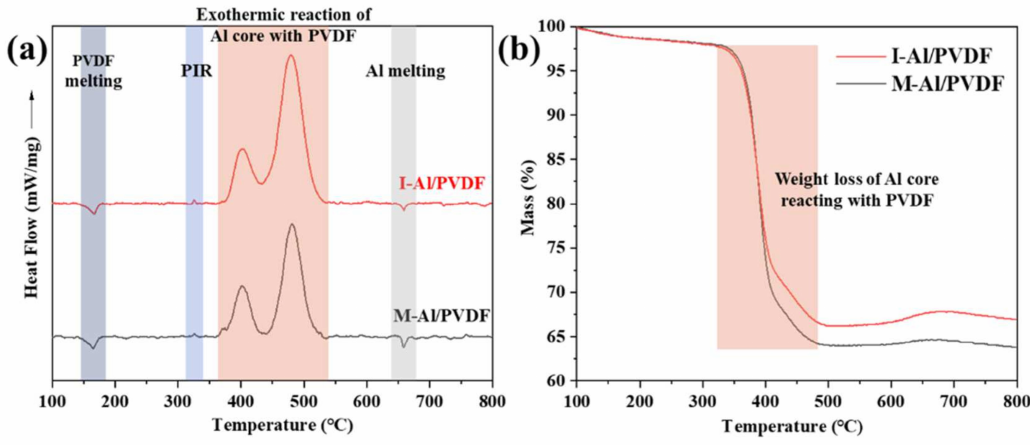
Figure 5. ( a ) DSC traces and ( b ) TGA traces of I-Al/PVDF and